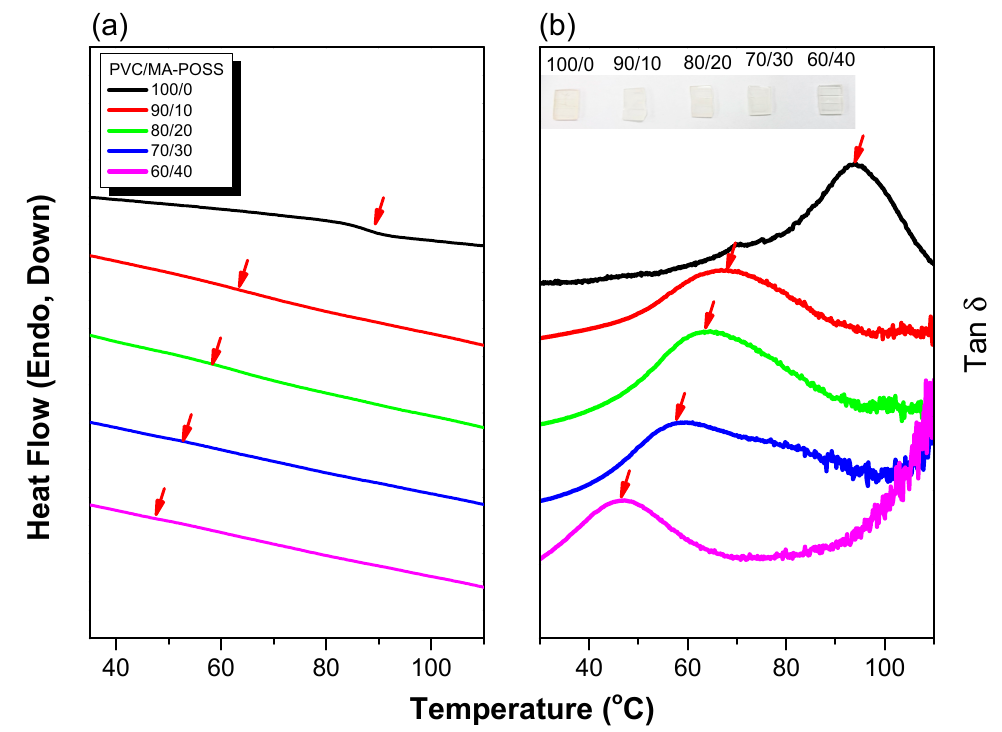
Figure 2. ( a ) Differential scanning calorimetry (DSC) and ( b ) dynamic mechanical analysis (DMA) of various PVC/MA-POSS blends; the inset to ( b ) displays the transparent films obtained after DMA analyses.